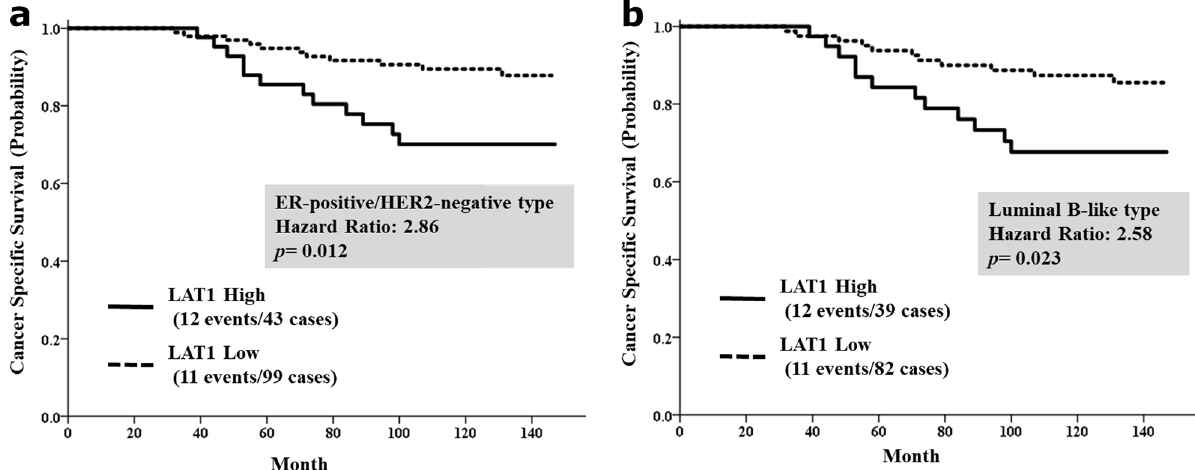
Figure 2. Breast cancer-specific survival stratified by L-type amino acid transporter 1 (LAT1) expression ( a ) in ER-positive and HER2-negative patients and ( b ) in luminal B-like